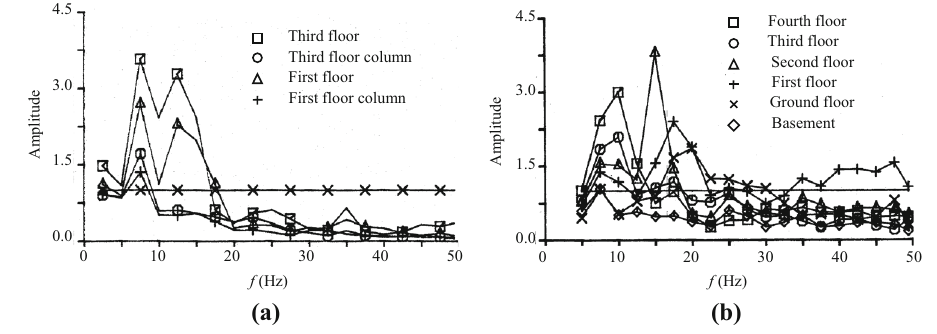
Fig. 15 Measured soil–building transfer functions of two office buildings: a a four-storey concrete building; b a six-storey steel-frame building Table 3 Parameters of square floors Boundary